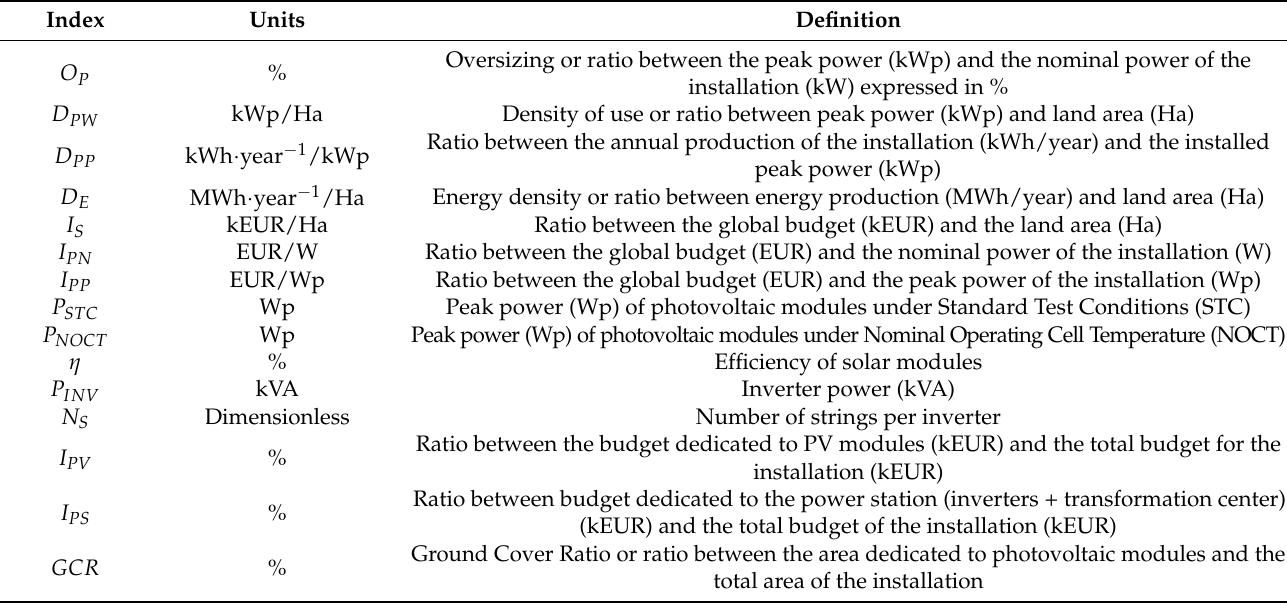
Table 2. Indicators defined in the benchmarking study applied to grid-connected PV plants in